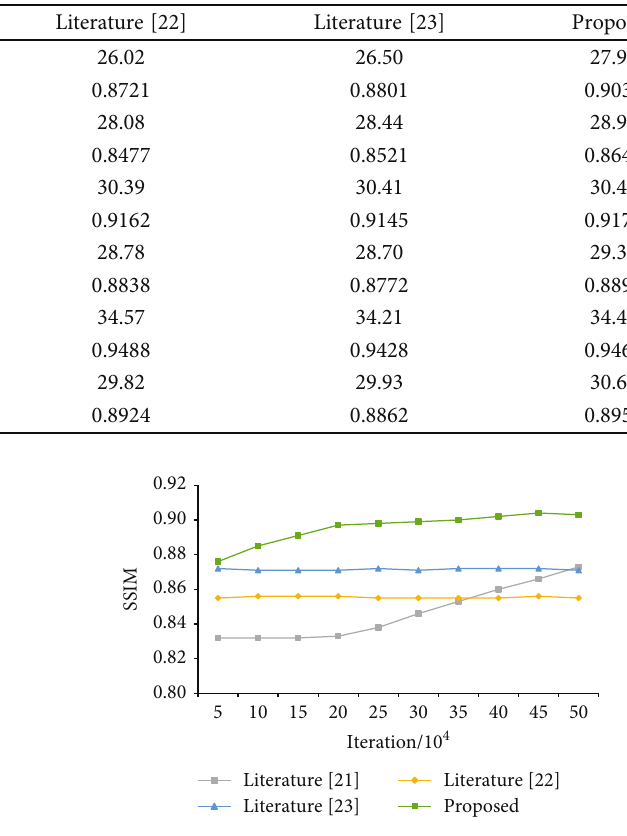
Figure 10: PSNR obtained by di ff erent algorithms. Figure 11: SSIM obtained by di ff erent